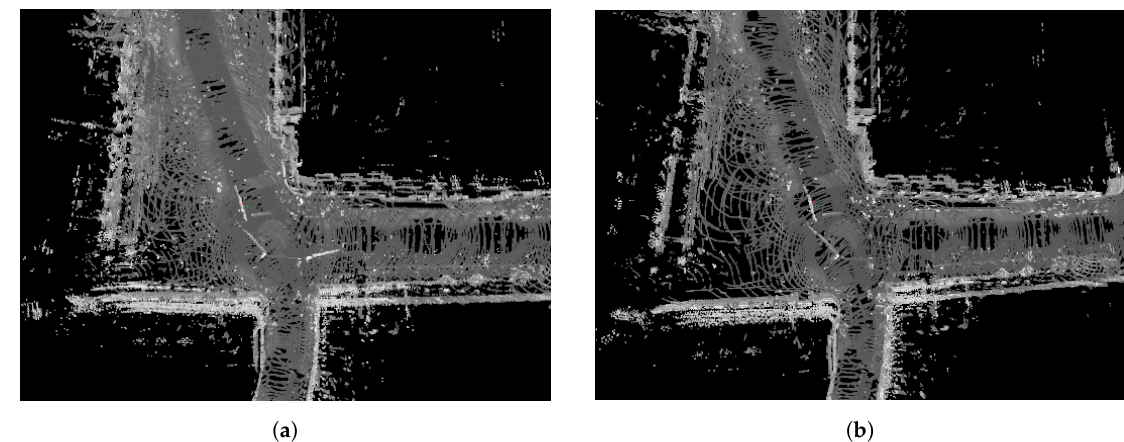
Figure 4. Comparison of an accumulated point cloud ( a ) before and ( b ) after the removal of repeated traversals as described in Section 3.1.3. The intuition behind this step is that natural environments, particularly those in an urban setting, are time variant. Different obstacles are likely present at different times of traversal, leading to the superposition of false phantom obstacles with the obstacles present at the time of capture of the radar scan. Both of the above effects mean any computed traversability labels (c.f. Section 3.2) will be a poor representation of the environment as seen by the radar scan and thus provide poor supervision. In this example, the vertical road segment becomes sparser and better